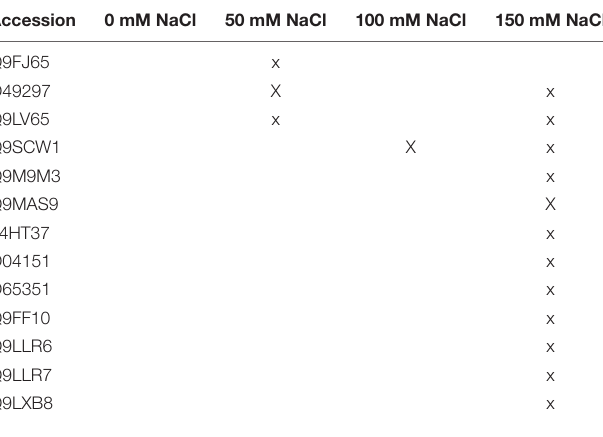
TABLE 2 | Plant proteins with predicted N-terminal secretion sequences in media with/without salt in the absence of the fungus. Accession